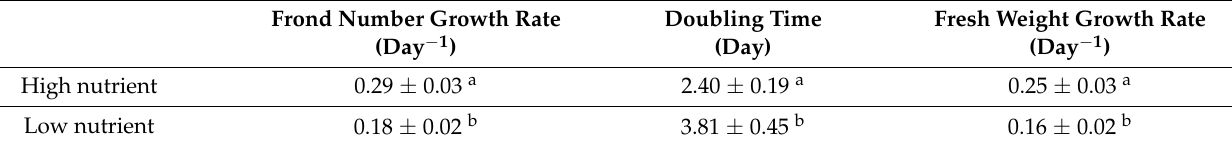
Figure 1. L. gibba plants grown under high and low total nitrogen and total phosphorus concentra- tions in nutrient solution.